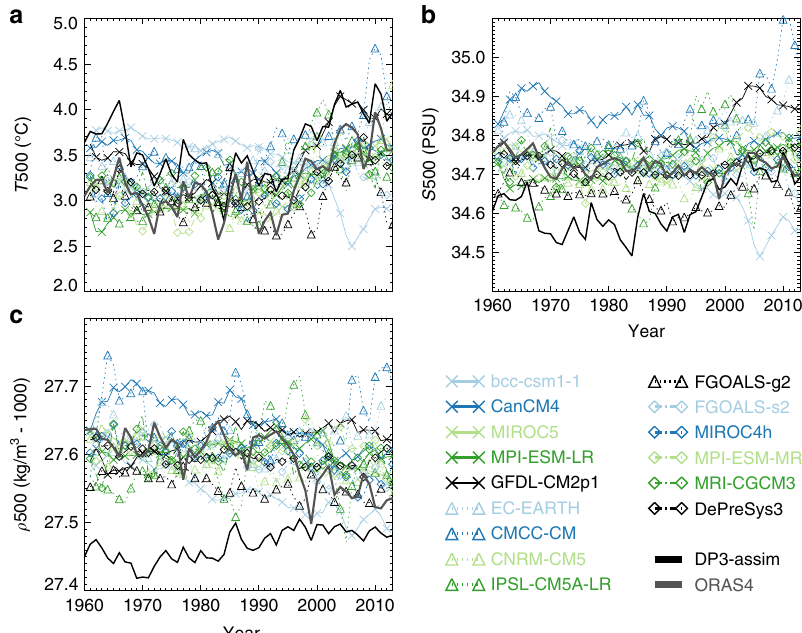
Fig. 1 Evolution of key quantities in the Labrador Sea. Time series of the volume averaged temperature ( T 500, a ), salinity ( S 500, b ), and density ( ρ 500, c ) in the Labrador Sea (45 – 60°W, 55 – 65°N) from the top 500 m in reanalyses and hindcast systems. For visual clarity, the hindcast systems are shown as grand ensemble means across all ensemble member and valid lead times for a given year with symbols and line styles as shown in the legend (identical in all fi gures). All hindcasts have been lead-time dependent bias corrected and mean-adjusted to compare to the ORAS4 reanalysis over the period from 1960 – 2013. The reanalyses are shown as solid lines without